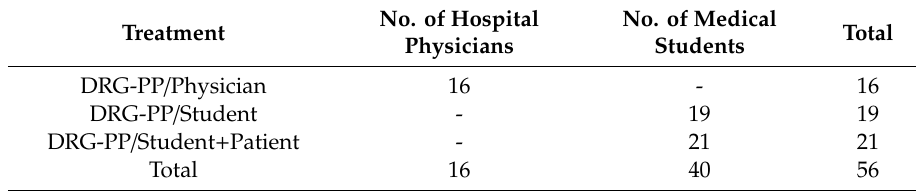
Table 1. Treatment Conditions.